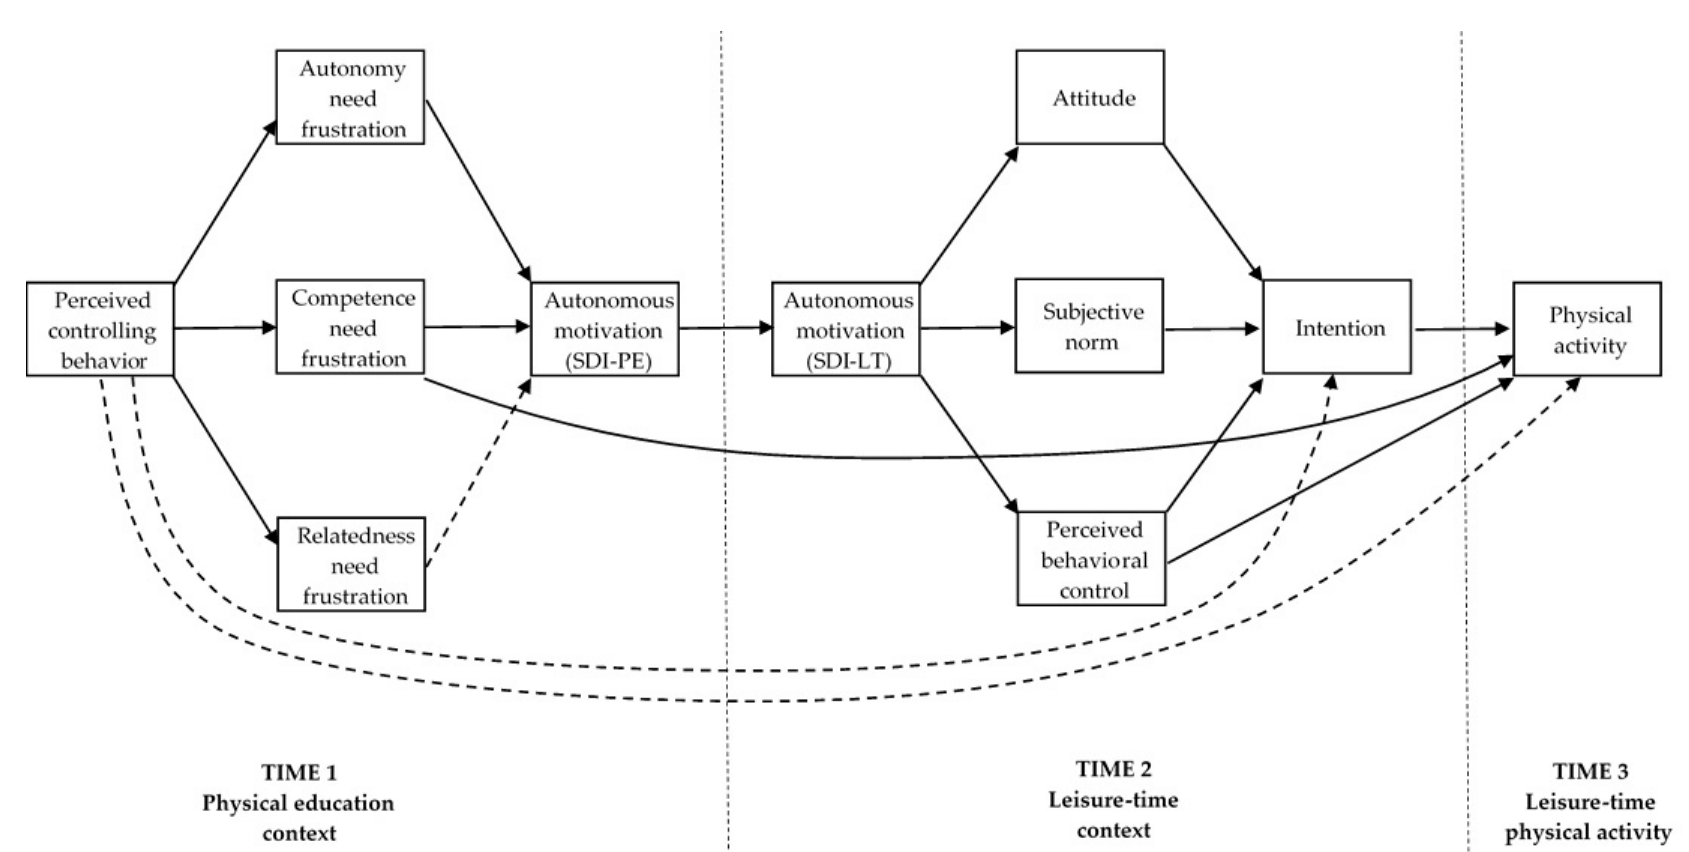
Figure 1. The hypothesized trans-contextual model. The following parameters have been omitted from the figure for clarity reasons: (i) direct paths from past physical activity behavior on all study variables; (ii) error covariances between psychological need frustration variables; and (iii) error covariances between attitude, subjective norm, and perceived behavioral control. The broken lines between constructs indicate direct effects that are assumed to be non-significant. SDI-PE = self-determination index in a physical education context; SDI-LT = self-determination index in a leisure-time context.